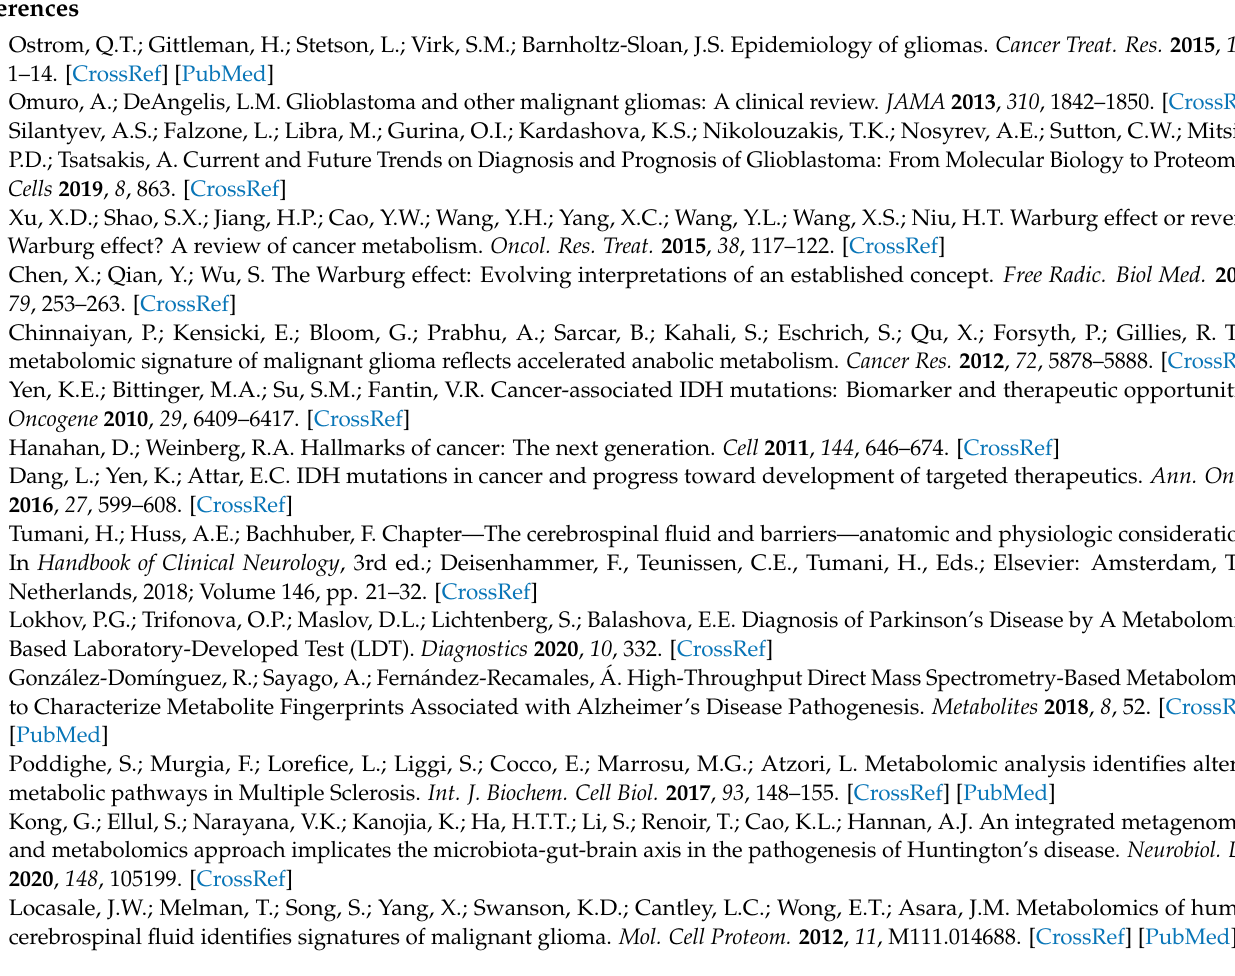
S6: Participants’ age distribution, Table S1: MRM data, Table S2: raw data, Table S3: statistics